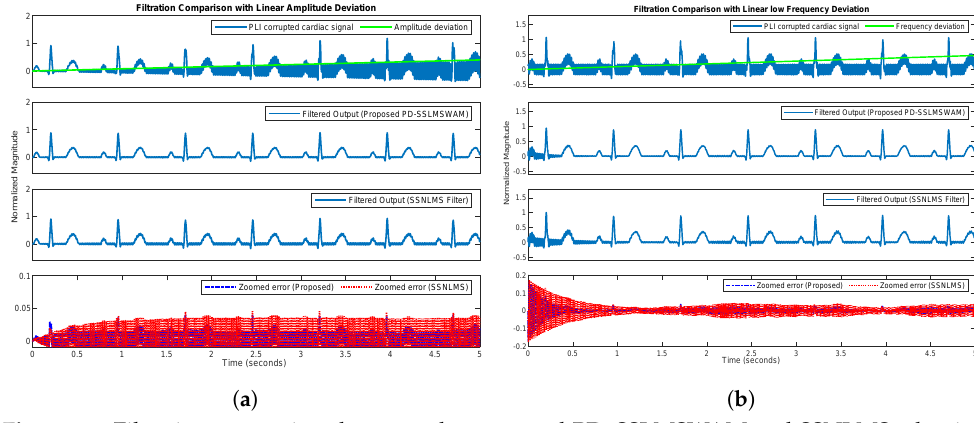
Figure 11. Filtration comparison between the proposed PD–SSLMSWAM and SSNLMS adaptive filters for the PLI-corrupted cardiac signals. ( a ) Linear change in the amplitude; ( b ) linear change in the frequency of the composite PLI signal.